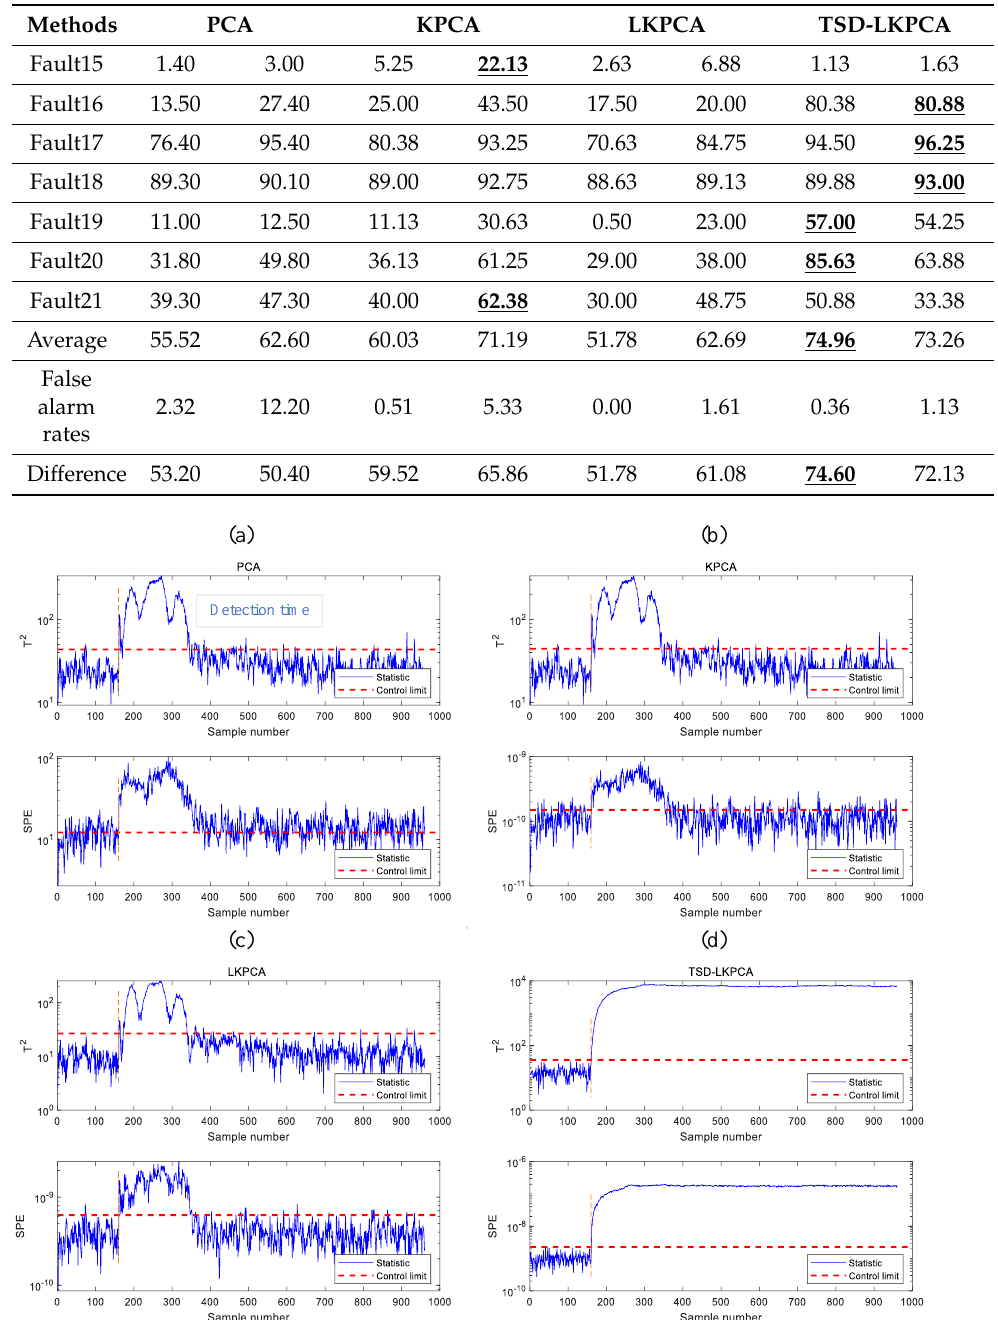
Figure 6. Monitoring charts of fault 5: ( a ) PCA, ( b ) KPCA, ( c ) LKPCA ( d ) TSD-LKPCA